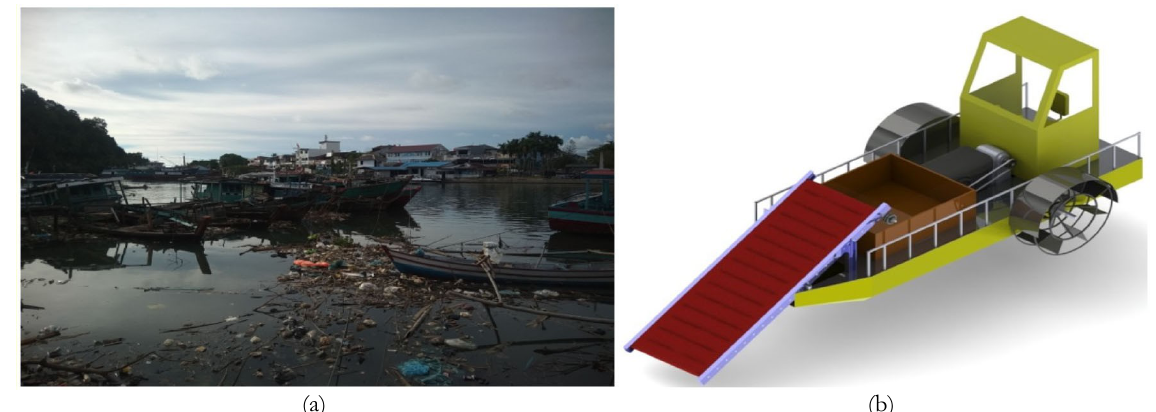
Figure 7. (a) the river in Siti Nurabaya Bridge, (b) the design of waste cleaning